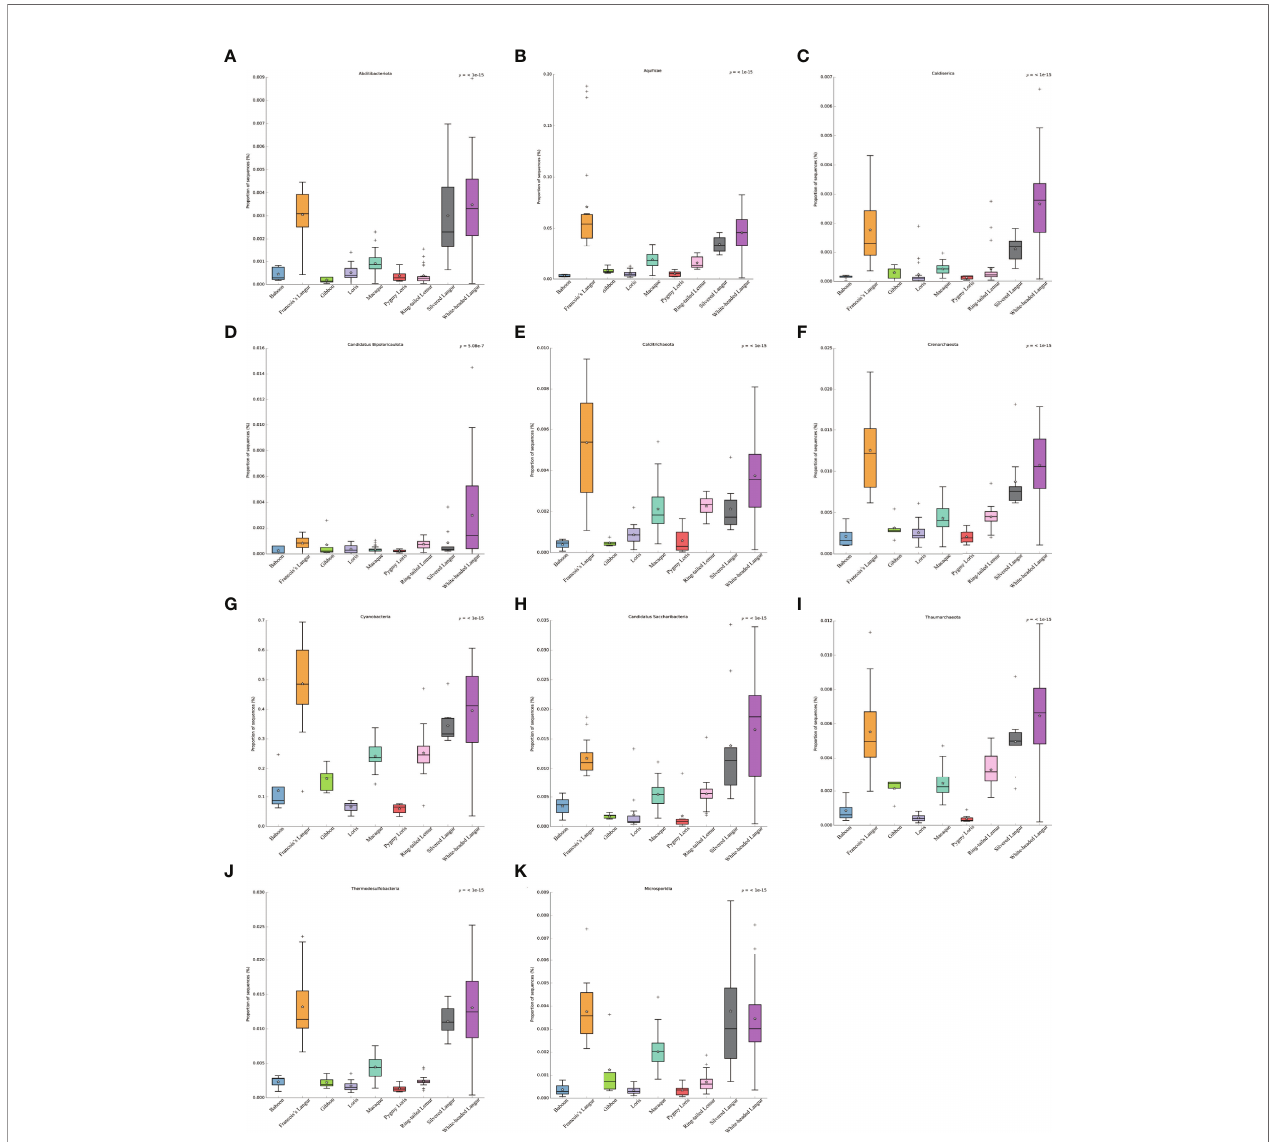
FIGURE 3 | Comparison of gut microbial composition between white-headed langur and other primates in phylum. (A – K) Abditibacteriota, Aqui fi cae, Caldiserica, Candidatus Bipolaricaulota, Calditrichaeota, Crenarchaeota, Cyanobacteria, Candidatus Saccharibacteria, Thaumarchaeota, Thermodesulfobacteria, and Microsporidia are presented in the form of box diagram